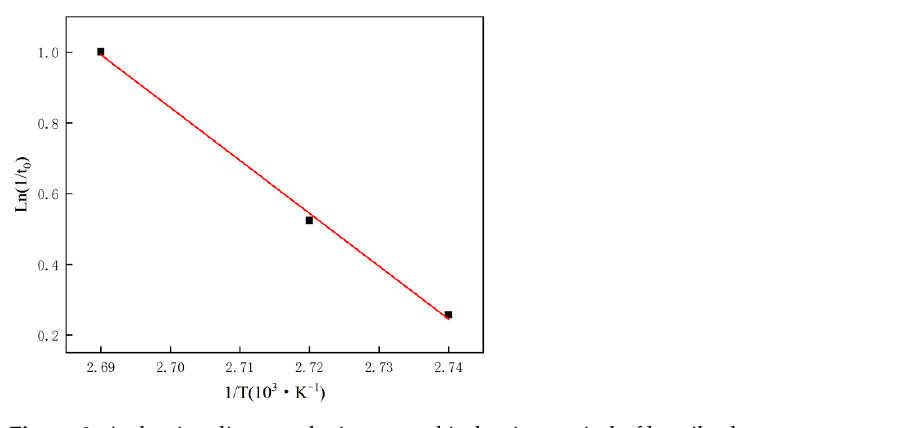
Figure 3. Arrhenius diagram during crystal induction period of hemihydrate gypsum prepared by hydrothermal method. Table 2. Activation energies (Ei), frequency factors (ln Ai), and fit coefficient (R 2 ) for the nucleation and growth stages of the α -HH crystallization .